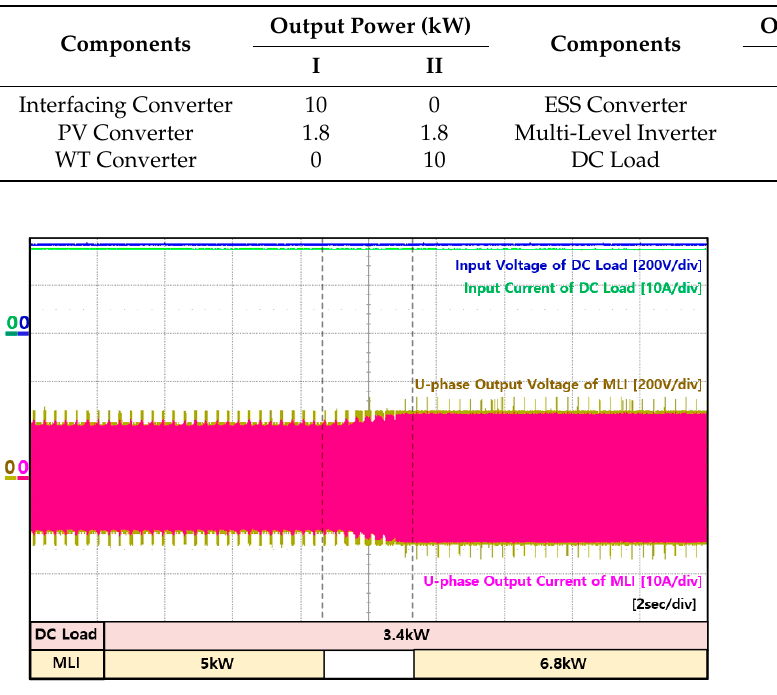
Figure 37. Experiment waveforms of DC load and multi-level inverter in mode 8.